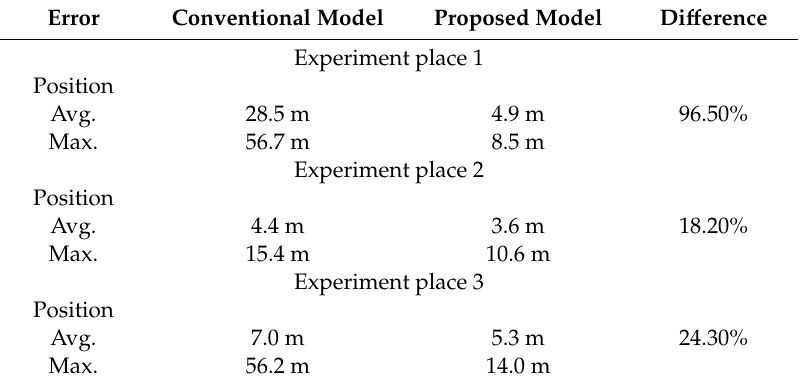
Table 4. Error for position estimation